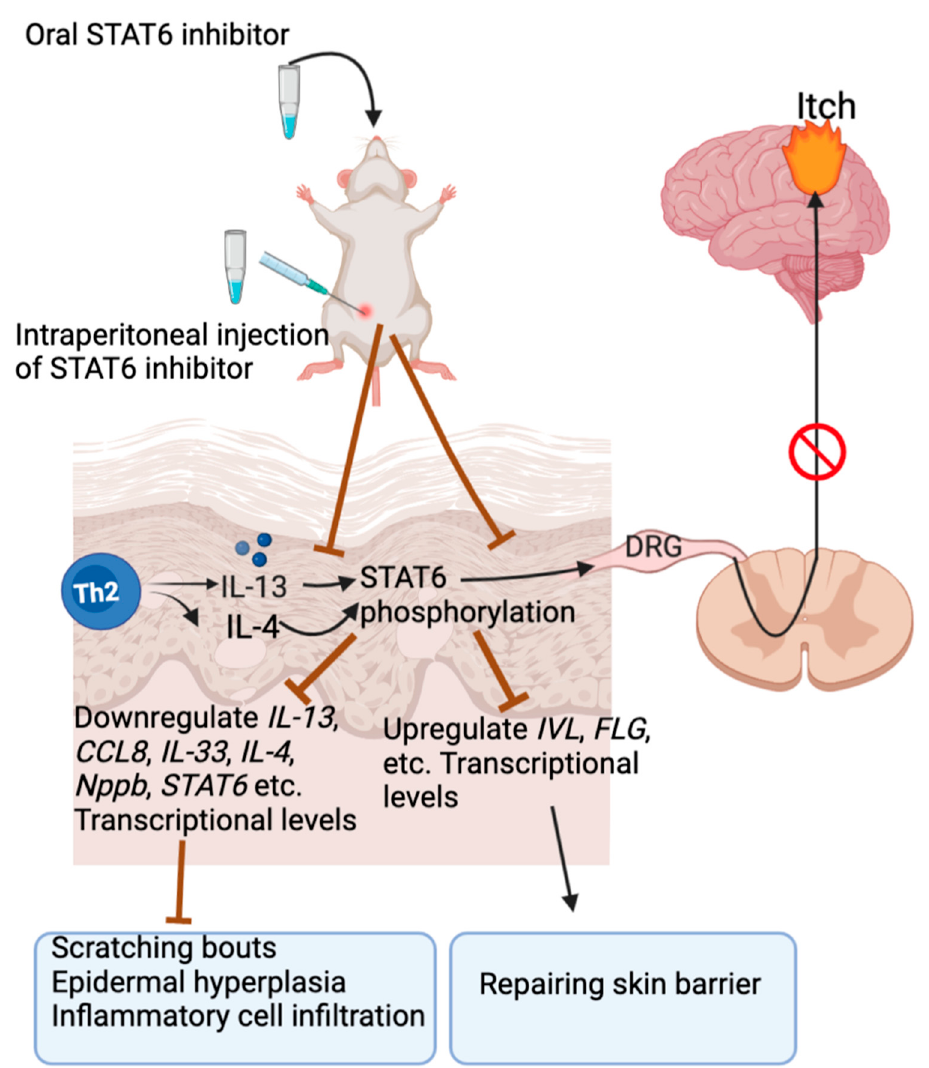
Figure 2. STAT6 mediates IL-13-induced itch signaling. IL-4 induces STAT6 activation in keratinocytes, and IL-13 triggers STAT6 activation to upregulate periostin and IL-24 expression, therefore both promoting skin barrier dysfunction via downregulation of filaggrin. STAT6 Y641 phosphorylation is upregulated in patient skins with AD. Pharmacological inhibition of STAT6 Y641 phosphorylation attenuates MC903-induced ear thickening, immune cell infiltration, and transcription of IL-13 , IL-4 , and CCL8 , while promotes transcripts involved in maintaining skin barrier. Both intraperitoneal and orally active inhibitors of STAT Y641 (namely AS1517499 and AS1810722) are effective in prevention of MC903-incuded itch and cutaneous inflammation.